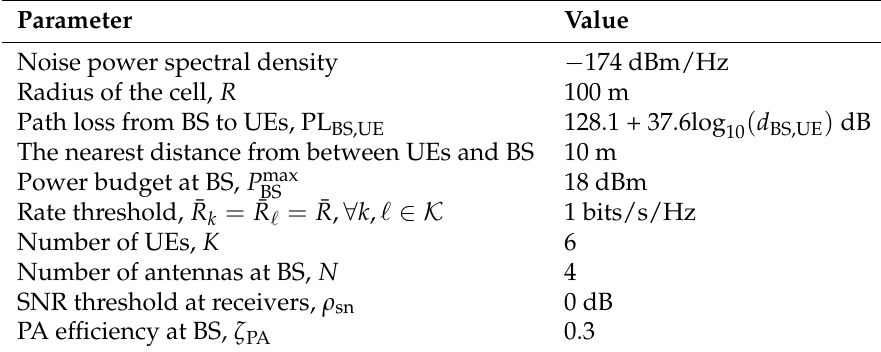
Table 1. Simulation Parameters.